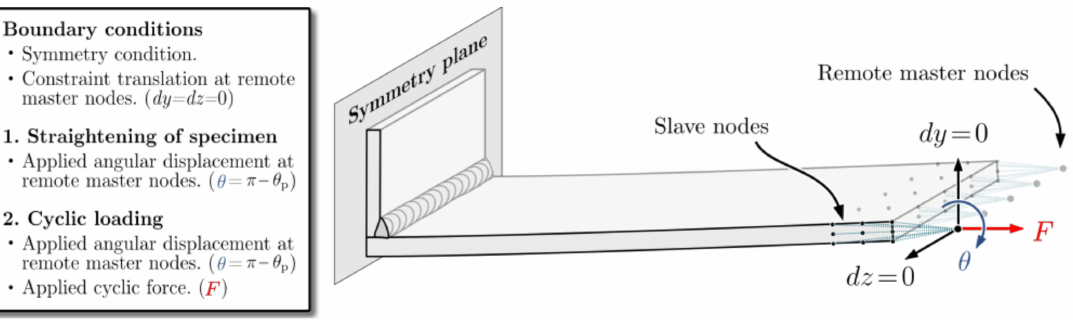
Figure 10. Boundary condition applied in the numerical simulations of the stress distribution.